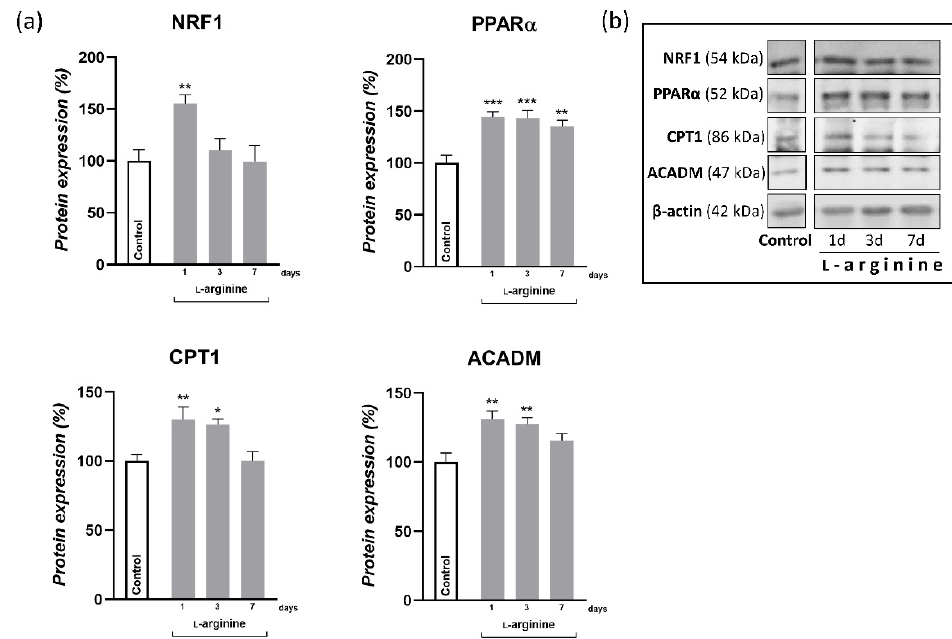
Figure 5. Protein content of nuclear respiratory factor 1 (NRF1), peroxisome proliferator-activated receptor- α (PPAR α ), carnitine palmitoyltransferase 1 (CPT1), and acyl-CoA dehydrogenase medium chain (ACADM) in retroperitoneal white adipose tissue (rpWAT) of rats receiving either drinking water or 2.25% L -arginine ∙ HCl in drinking water for 1, 3, and 7 days. Data obtained after quantification of specific bands and expressed as % of the control group taken as 100% represent the mean ± SEM ( a ). Each band is representative of six pooled samples per group ( b ). Experiments were repeated in triplicate. Data were quantified as described in the Methods. * Comparison between control and L -arginine-treated group; * p < 0.05, ** p < 0.01, *** p < 0.001.